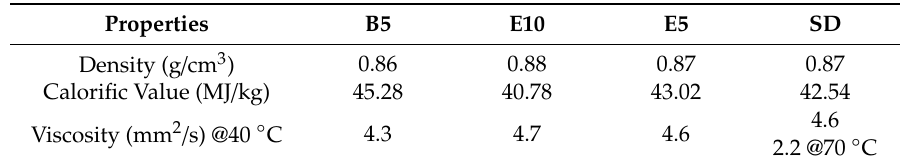
Table 3. Properties of fuels.